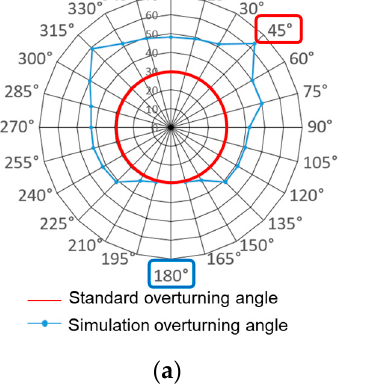
Figure 12. The rollover angles for the attached weights at the rear of the radish harvester: ( a ) 50 kg, ( b ) 100 kg, and ( c ) 150 kg.